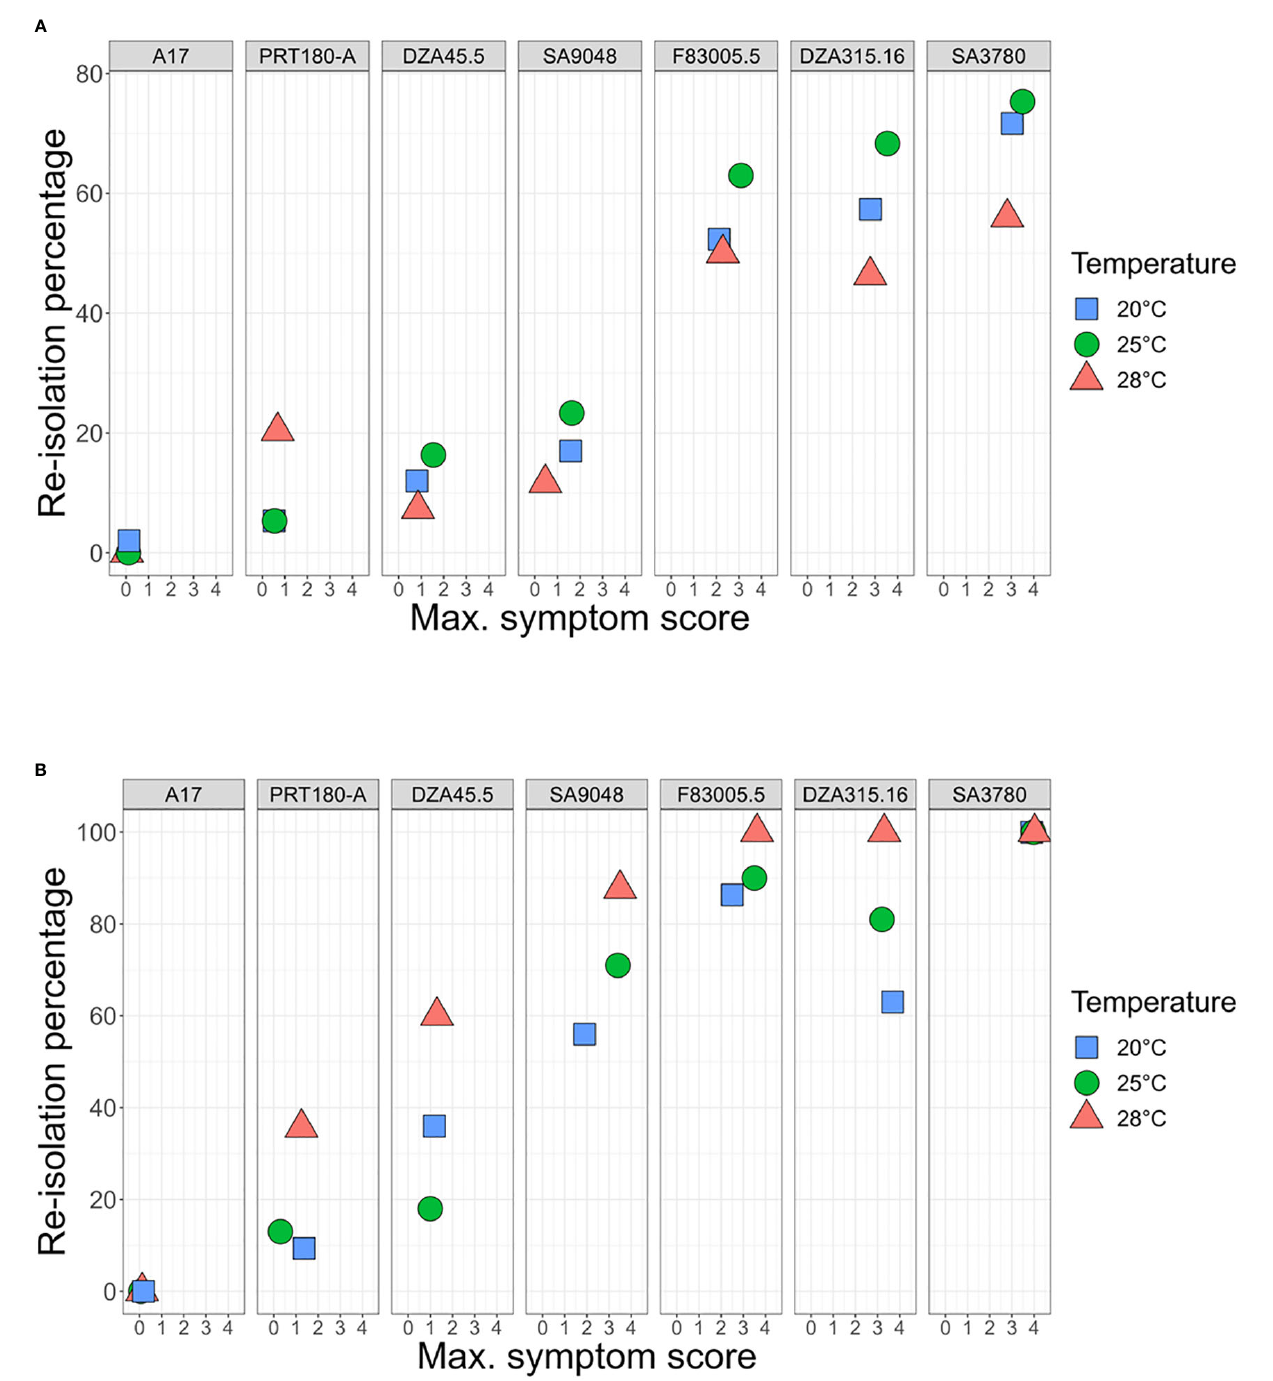
FIGURE 5 Assessment of Quantitative Disease Resistance (QDR) of M. truncatula to V. alfalfae V31-2 and AS38 its derived mutant at different temperatures, using Maximum Symptom Score and plant colonization evaluation. Seven M. truncatula lines (A17, PRT180-A, DZA45.5, SA09048, F83005.5, DZA315,16 and SA03780) were root-inoculated with a spore suspension of Verticillium strains V31-2 (A) and AS38 (B) and maintained at 20°C, 25°C and 28°C. Symptoms were scored regularly on a scale from 0 to 4 during four weeks. At the end of the experiment, maximum symptom scores were determined, and stem sections were harvested for fungus re-isolation. The values for MSS and re-isolation percentage are means from three independent experiments, with at least eight plants each. Bars indicate standard error of mean